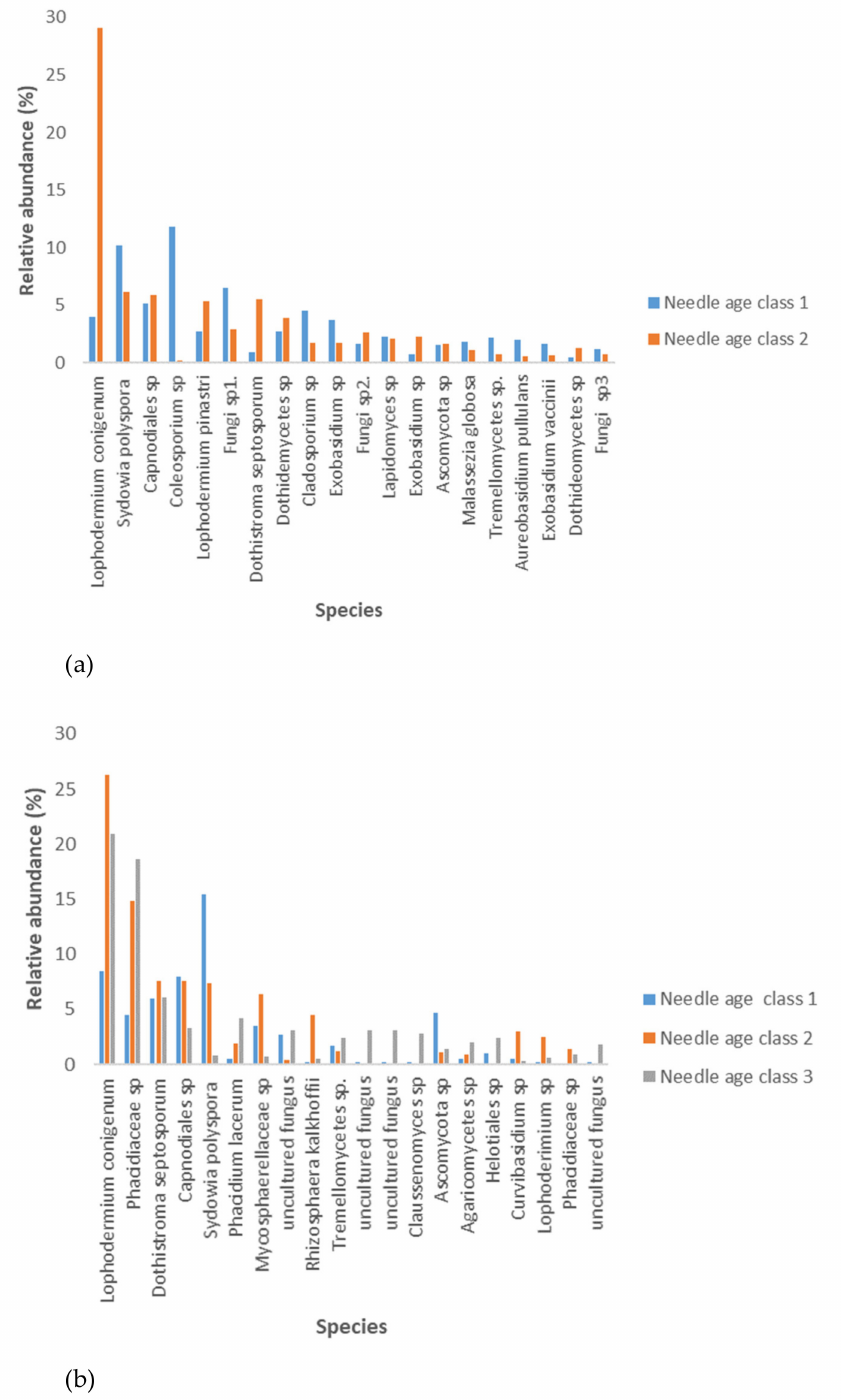
Figure 4. Twenty most abundant fungal OTUs in Estonia ( a ) and Norway ( b ) in needles with different ages (n =